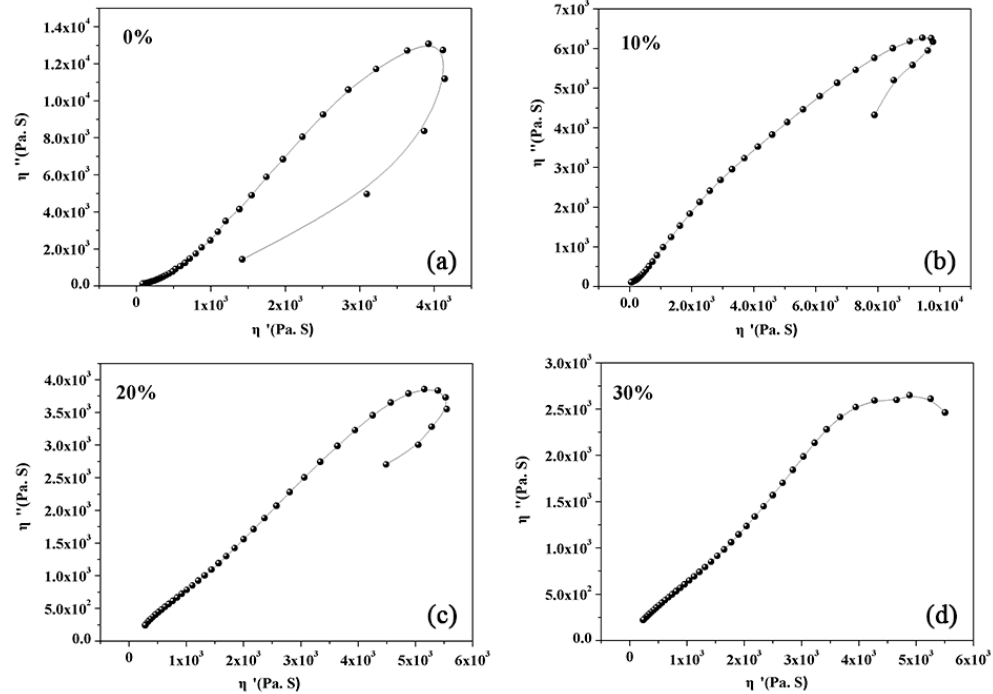
Figure 6. Cole-Cole plot curves of BT@ZnPc-2/PEN composite with 0 wt% ( a ); 10 wt% ( b ); 20 wt% ( c ) and 30 wt% ( d ) of BT@ZnPc-2.